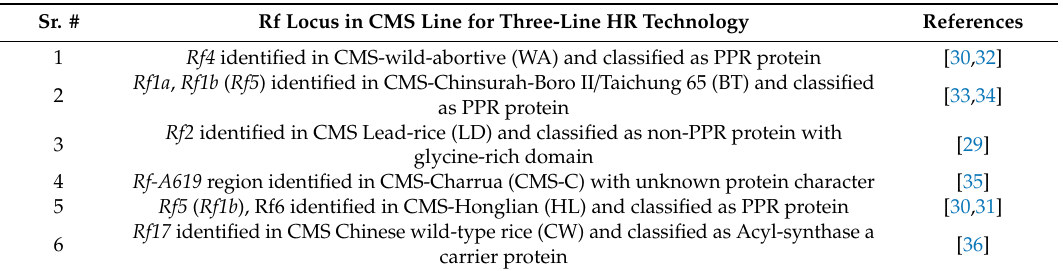
Table 1. Characterization of fertility restoring Rf